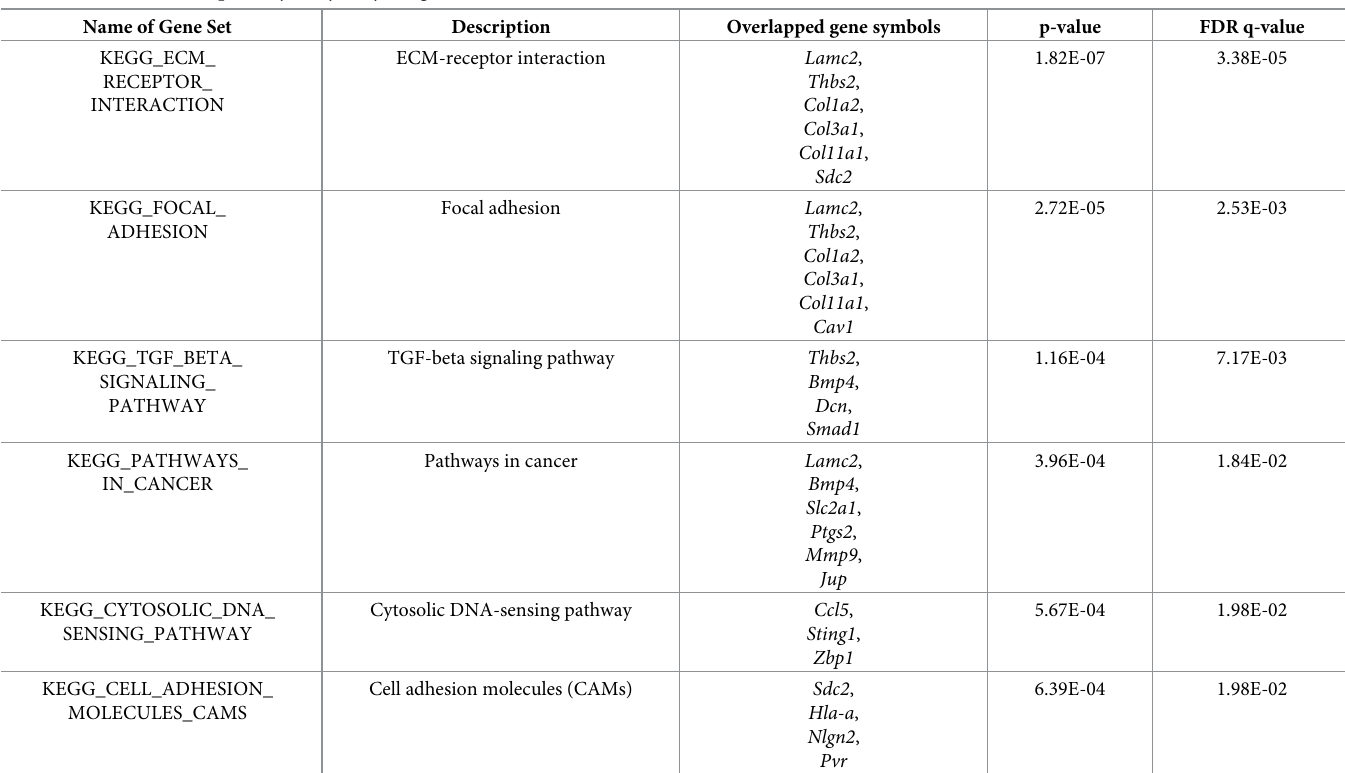
Table 3. Details of KEGG pathway analysis by